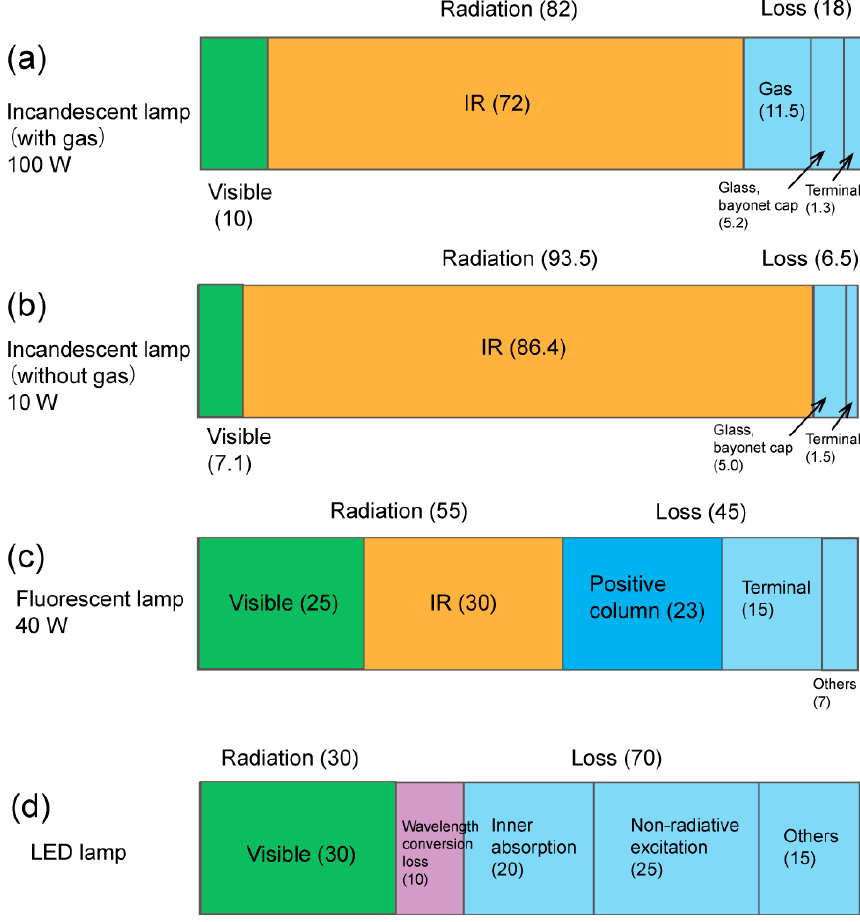
Figure 2. The power flow ratio (percentage) of typical commercial light sources: ( a ) an incandescent light bulb with inert gases (100 W) [36,37], ( b ) an incandescent light bulb without inert gases (10W) [38], ( c ) a fluorescent lamp (40 W) [39], and ( d ) a light-emitting diode (LED) light bulb (blue LED + yellow phosphor) [40].